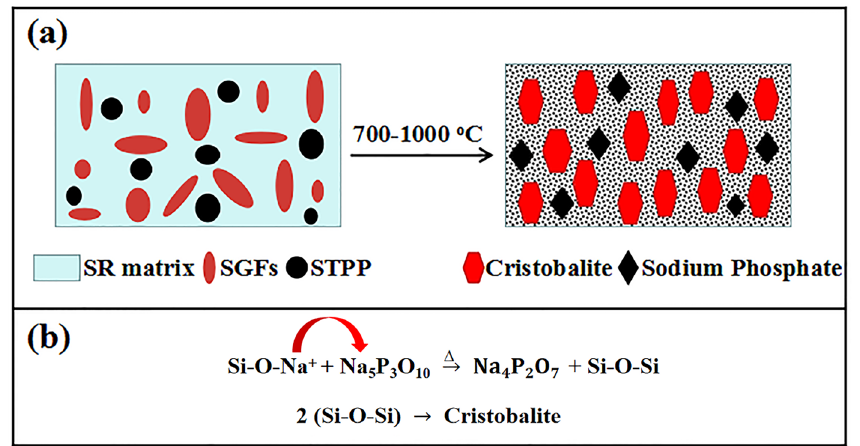
Figure 10. ( a ) Schematic illustrations and ( b ) chemical reaction process of the formation of cristobalite at high temperatures.